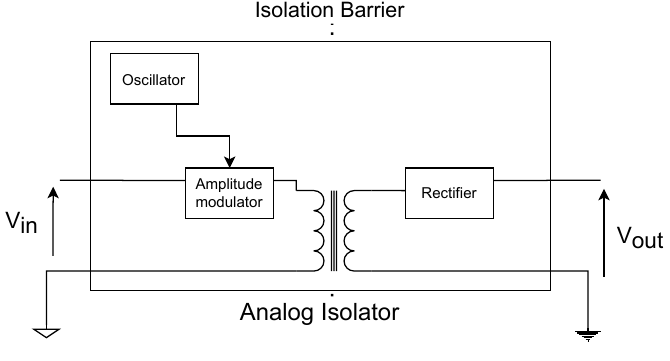
Figure 1. Analog Isolator